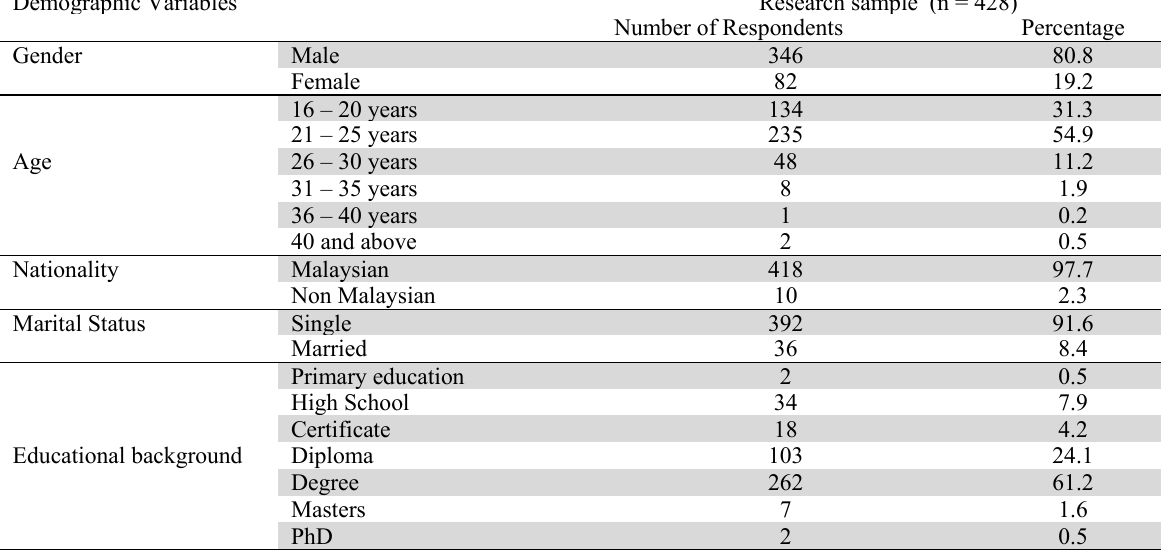
Demographic Profile of the Respondents Demographic